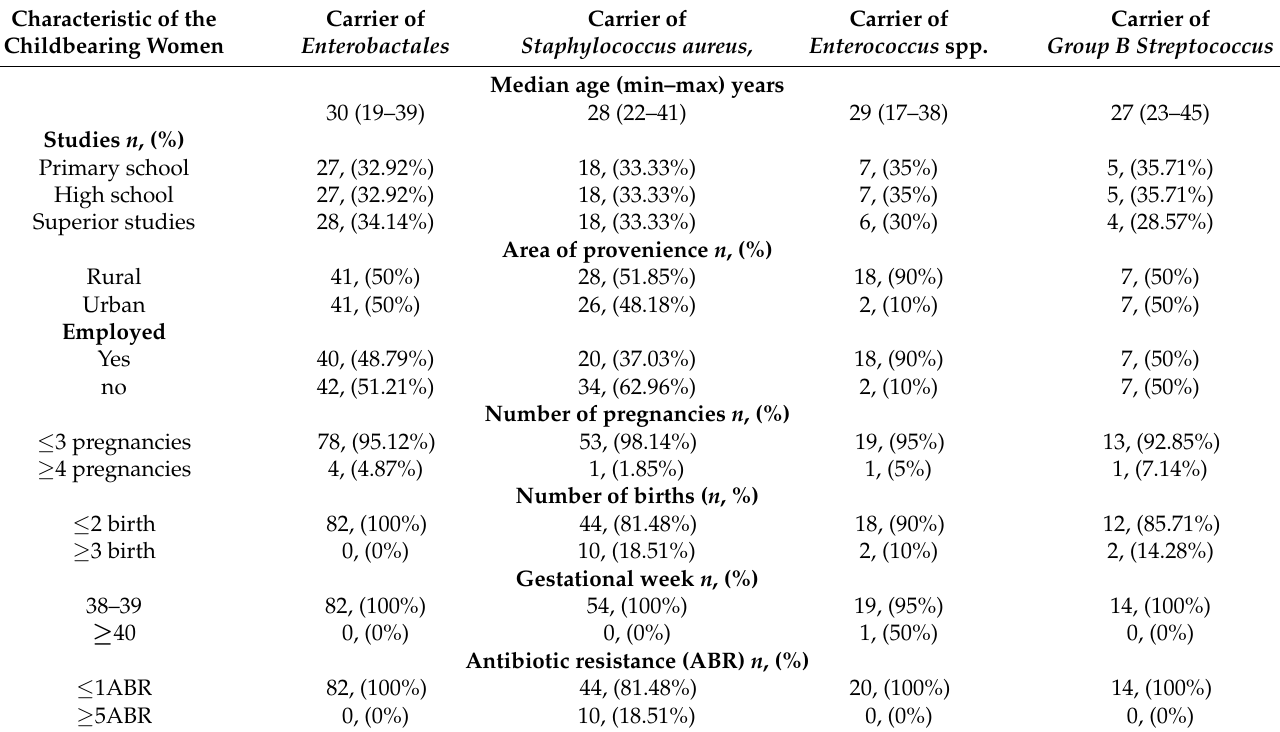
Table 1. Pregnancy status, sociodemographic, and educational characteristics, baseline clinical data of 170 childbearing women that tested positive for bacteria and gave birth by